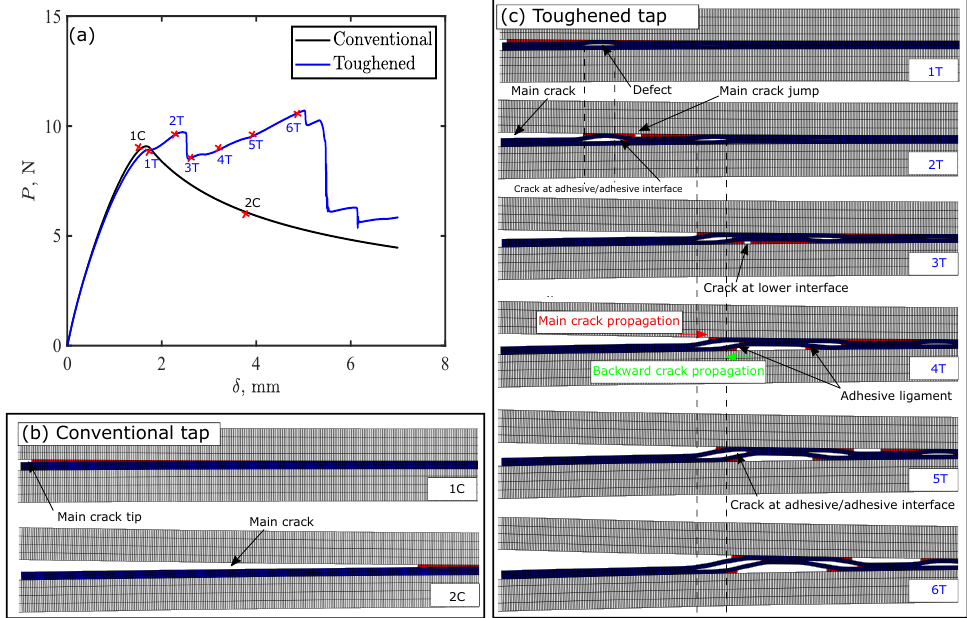
Figure 9. Toughening mechanisms in thermoplastic adhesive tapes with 2 mm crack length and 5 mm gap between cracks: ( a ) load-displacement curves for double cantilever beam (DCB) simulation; and crack propagation in ( b ) conventional tape and ( c ) toughened